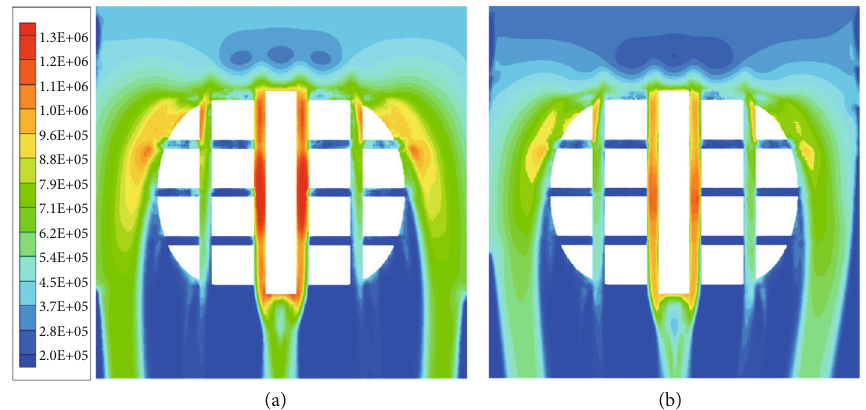
Figure 15: Distributions of hydrodynamic pressure. (a) Smooth-groove tire; (b) Bionic tire.